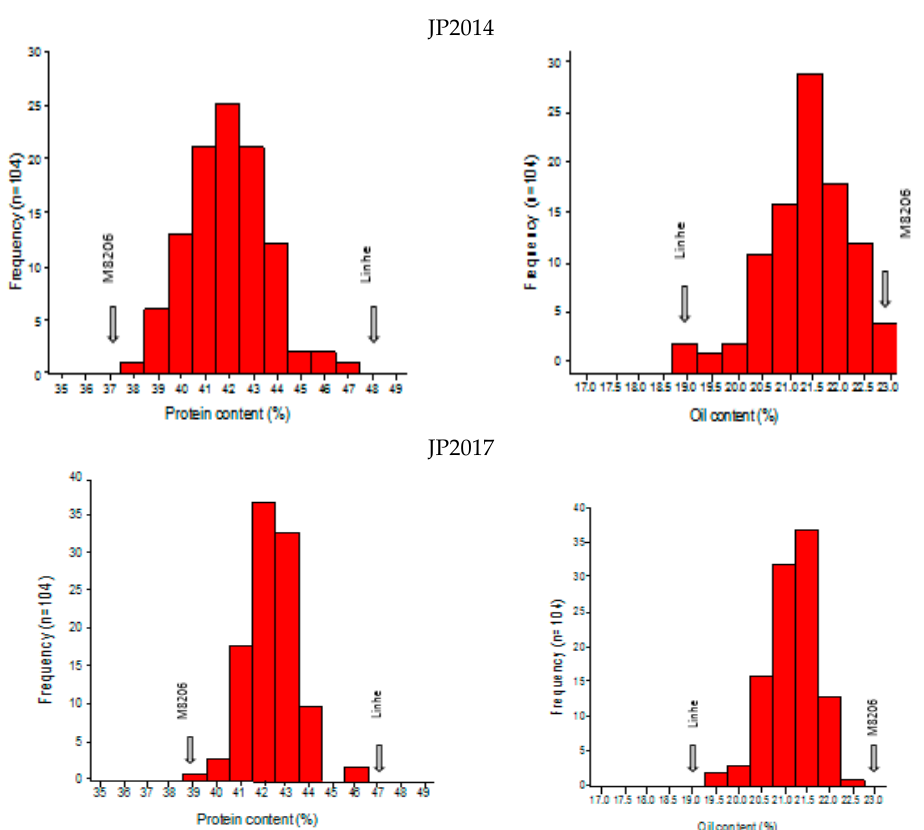
Figure 1. Frequency distribution of seed protein and oil content among the RILs and parents of LM6 population in six different environments (FY2012, JP2012, JP13, JP2014, YC2014 and JP2017).